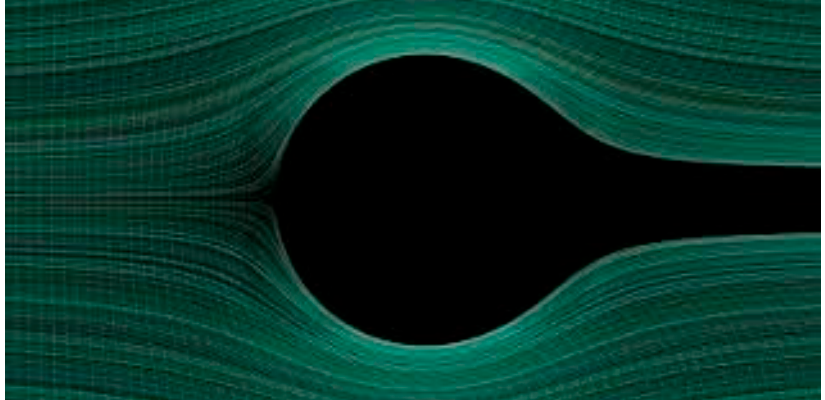
Figure 5. An example of laminar flow.